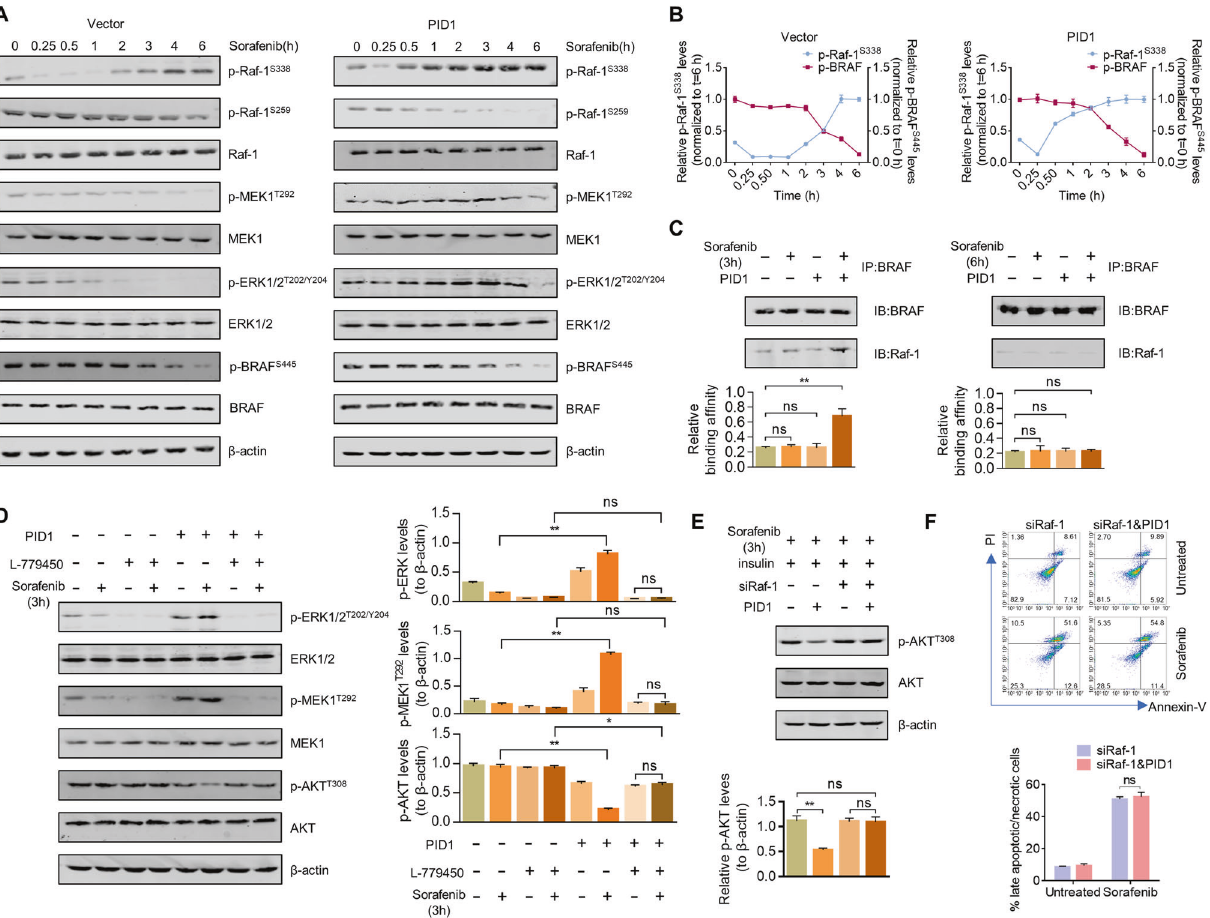
Fig. 6 PID1 altered the rhythmicity of pharmacological activity of Sorafenib on Raf-1 and AKT. A Time-course analysis of p-Raf-1 S338 , p-Raf- 1 S259 , p-MEK1 T292 , p-ERK1/2 T202/Y204 , BRAF and p-BRAF S445 in HepG2 cells with or without PID1 overexpression upon Sorafenib (10 μ M) treatment. B Dynamics of Raf-1 activation and BRAF inactivation in HepG2 cells with or without PID1 overexpression upon Sorafenib (10 μ M) treatment. p-Raf-1 S338 band density was normalized to actin and then normalized to t = 6 h. p-BRAF S445 band density was normalized to actin and then normalized to t = 0. C Endogenous interaction between Raf-1 and BRAF in HepG2 cells with or without PID1 overexpression upon Sorafenib (10 μ M) treatment for 3 h or 6 h was examined by co-immunoprecipitation assay. D Western blot analysis of ERK1/2, p-ERK1/2 T202/ Y204 , MEK1, p-MEK1 T292 , AKT, p-AKT T308 and β -actin in HepG2 cells with or without PID1 overexpression upon Sorafenib (10 μ M) treatment for 3 h in the presence of L-779450 (20 μ M). E HepG2 cells with or without PID1 overexpression upon Raf-1 knockdown were pretreated with Sorafenib (10 μ M) for 3 h and then treated with insulin for 0.25 h. Western blot analysis of AKT, p-AKT T308 and β -actin was performed. F Cell apoptosis in HepG2 with or without PID1 overexpression combined with Raf-1 knockdown upon Sorafenib (10 μ M) treatment for 24 h was examined by cytometry analysis. Data are expressed as mean ± SD ( n = 3). * p < 0.05; ** p < 0.01; ns not signi fi